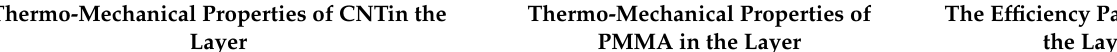
Table 2. Properties of nanocomposites and efficiency parameters in the layers.